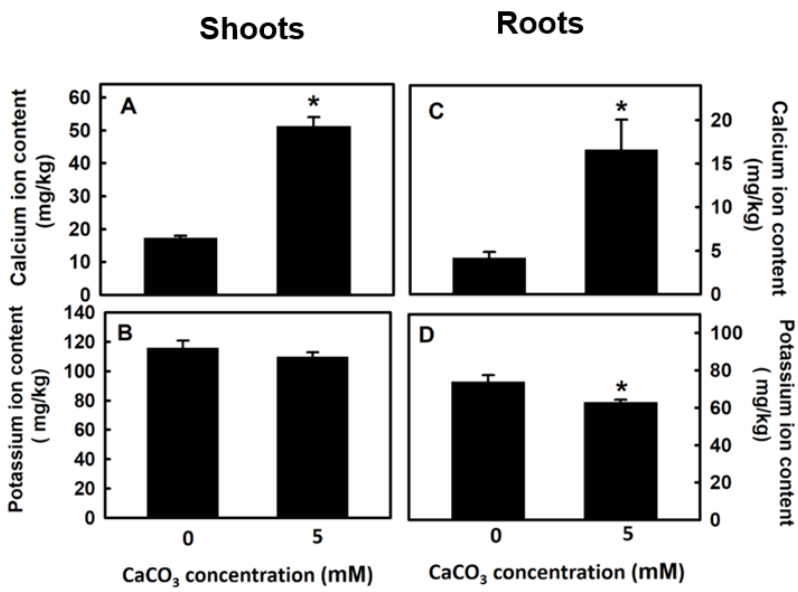
Figure 5. The effect of calcium carbonate on Na + and K + content of Djulis sprouts. The 7-d-old dju- lis plants were treated with 5 mM CaCO 3 for 5 days. The Ca + content of the shoot ( A ) and the root ( C ), and K + content of the shoot ( B ) and the root ( D ) of djulis were measured. Bars show means ± SE ( n = 4). Asterisks represent values that are significantly different between calcium carbonate concentration 0 mM and 5 mM at p < 0.05.